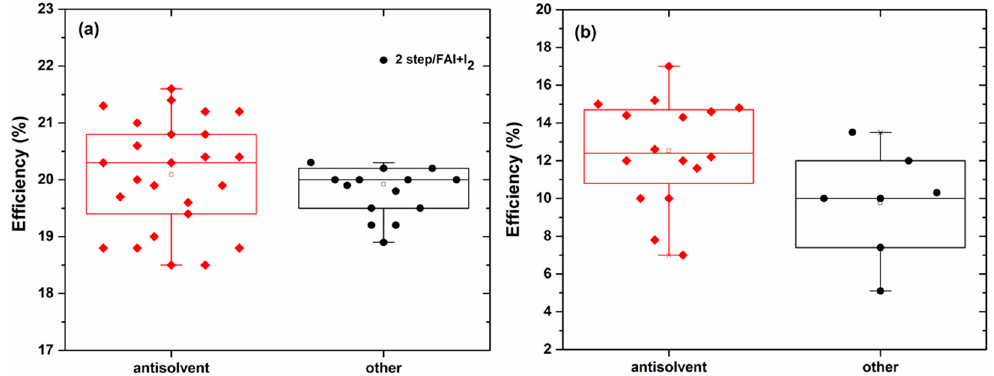
Figure 5. Overall photovoltaic efficiencies of (various types of) perovskite solar cells with perovskite films fabricated via a combined intermediate/anti-solvent crystallization method: ( a ) solar cells based on pure Pb 2+ perovskite and ( b ) solar cells based on mixed Pb/Sn perovskites. Note that in the case of pure lead perovskite solar cells, only efficiencies higher than 18.5% were introduced in the statistical analysis. Data were taken from the references existing in the present manuscript.